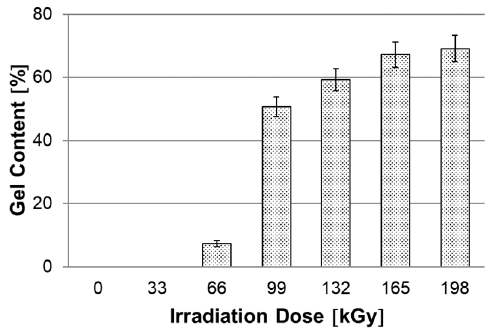
Figure 4. Dependence of gel content on irradiation dose.